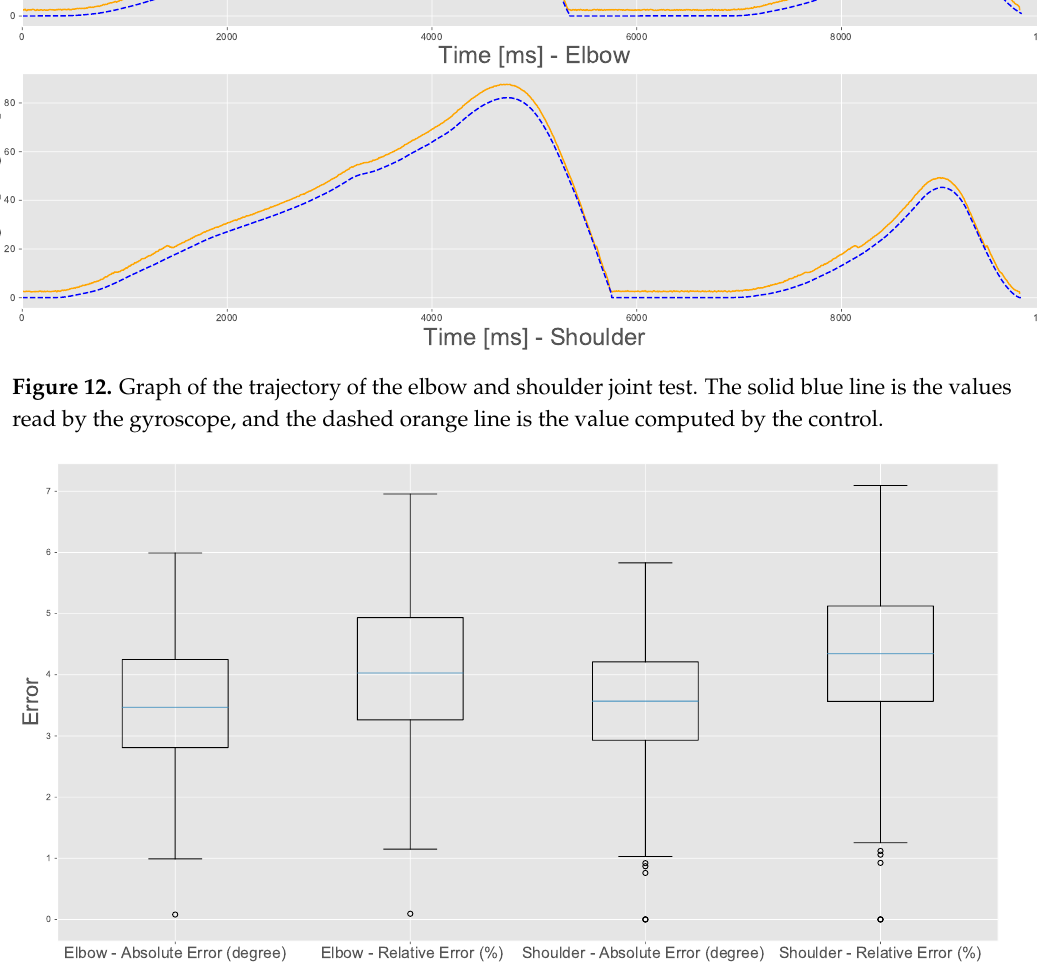
Figure 13. Analysis of the absolute and normalized error of the control of two degrees of